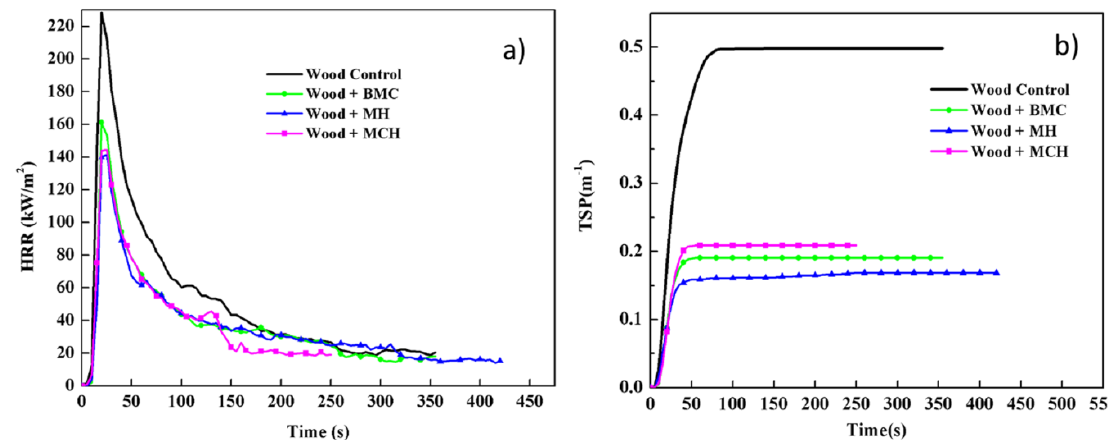
Table 1. Values of combustion parameters for untreated and treated red gum wood samples. Sample